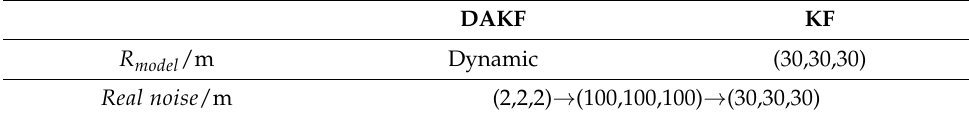
Table 1. Experimental parameters.